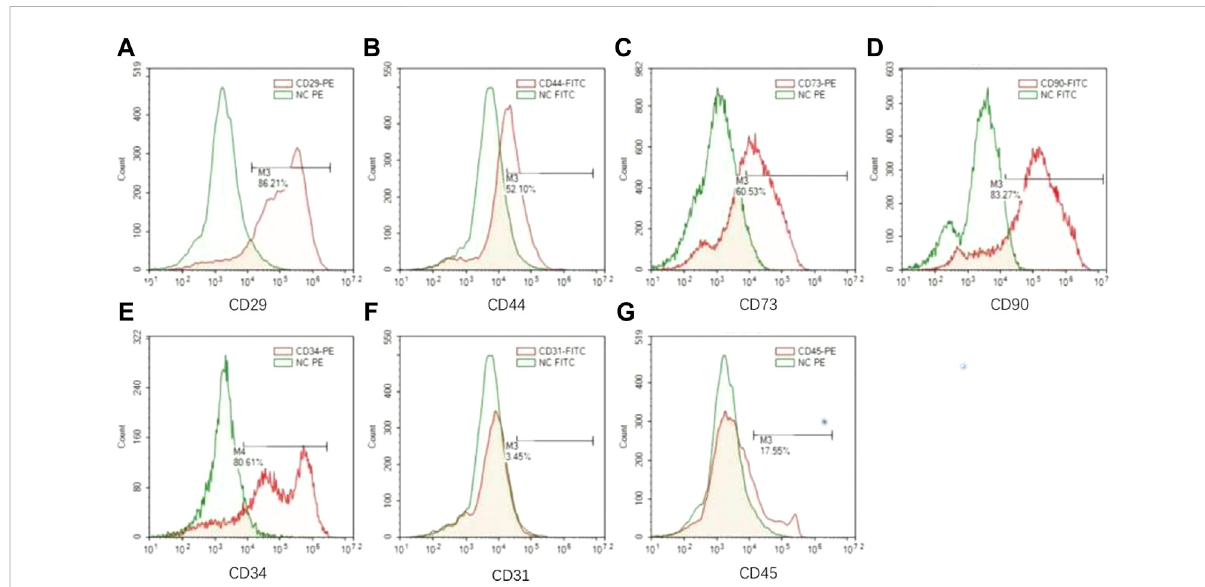
FIGURE 4 The surface markers ofLPCs. (A – G) Flow cytometryanalysis for CD29,CD44, CD73, CD90, CD34, CD31,CD45 in LPCs. Green colorhistogram represents isotype negtive control, red color histogram represents cells stained with fl uorescent antibodies. And the positive range selected performs the representative percentage of the positive population for each marker.